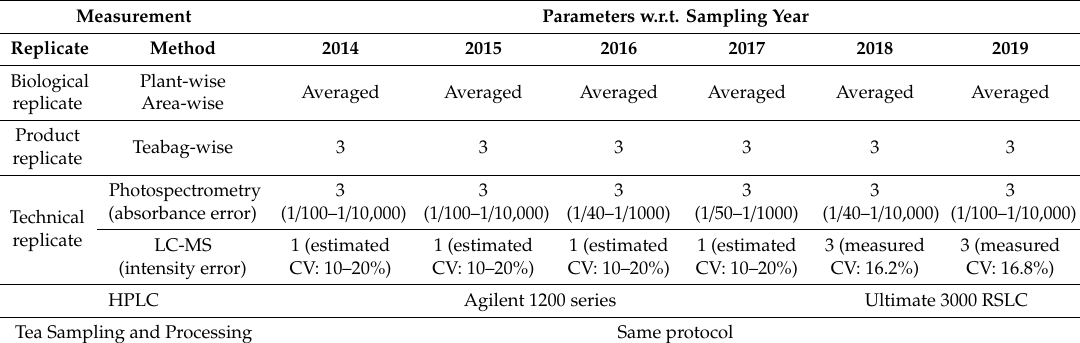
Table 1. Summary of the sample replicates and LC-MS analysis method.